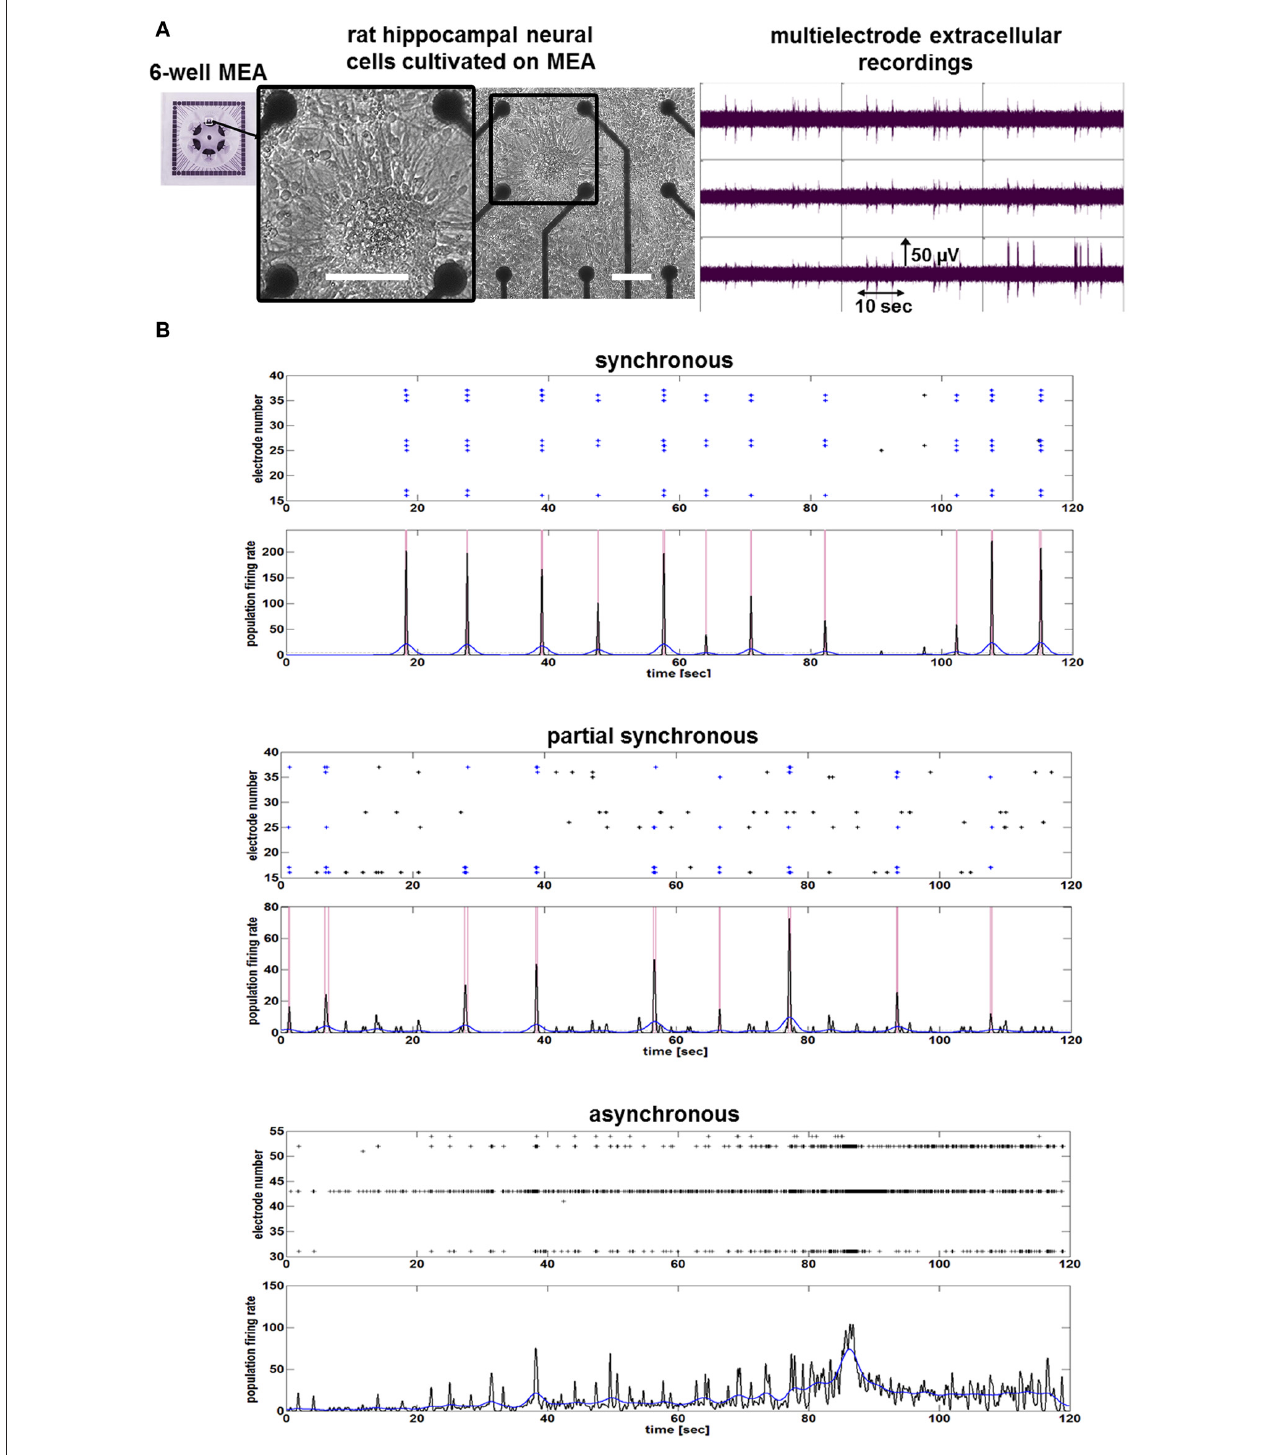
FIGURE 1 | Neuronal network activity of mature rat hippocampal neuronal cultures. (A) Images show morphology and neuronal network activity of rat hippocampal neuronal cells cultivated on a nine-electrode array (28 div) of a six-well multi-electrode array (MEA). White bars represent scale bars (100 µ m). Image with black frame shows detailed morphology of neuronal cells cultivated on MEA. (B) Examples of spike raster plots and population firing ratesillustrate the activity of one synchronous, one partial synchronous and one asynchronous rat hippocampal neuronal network.